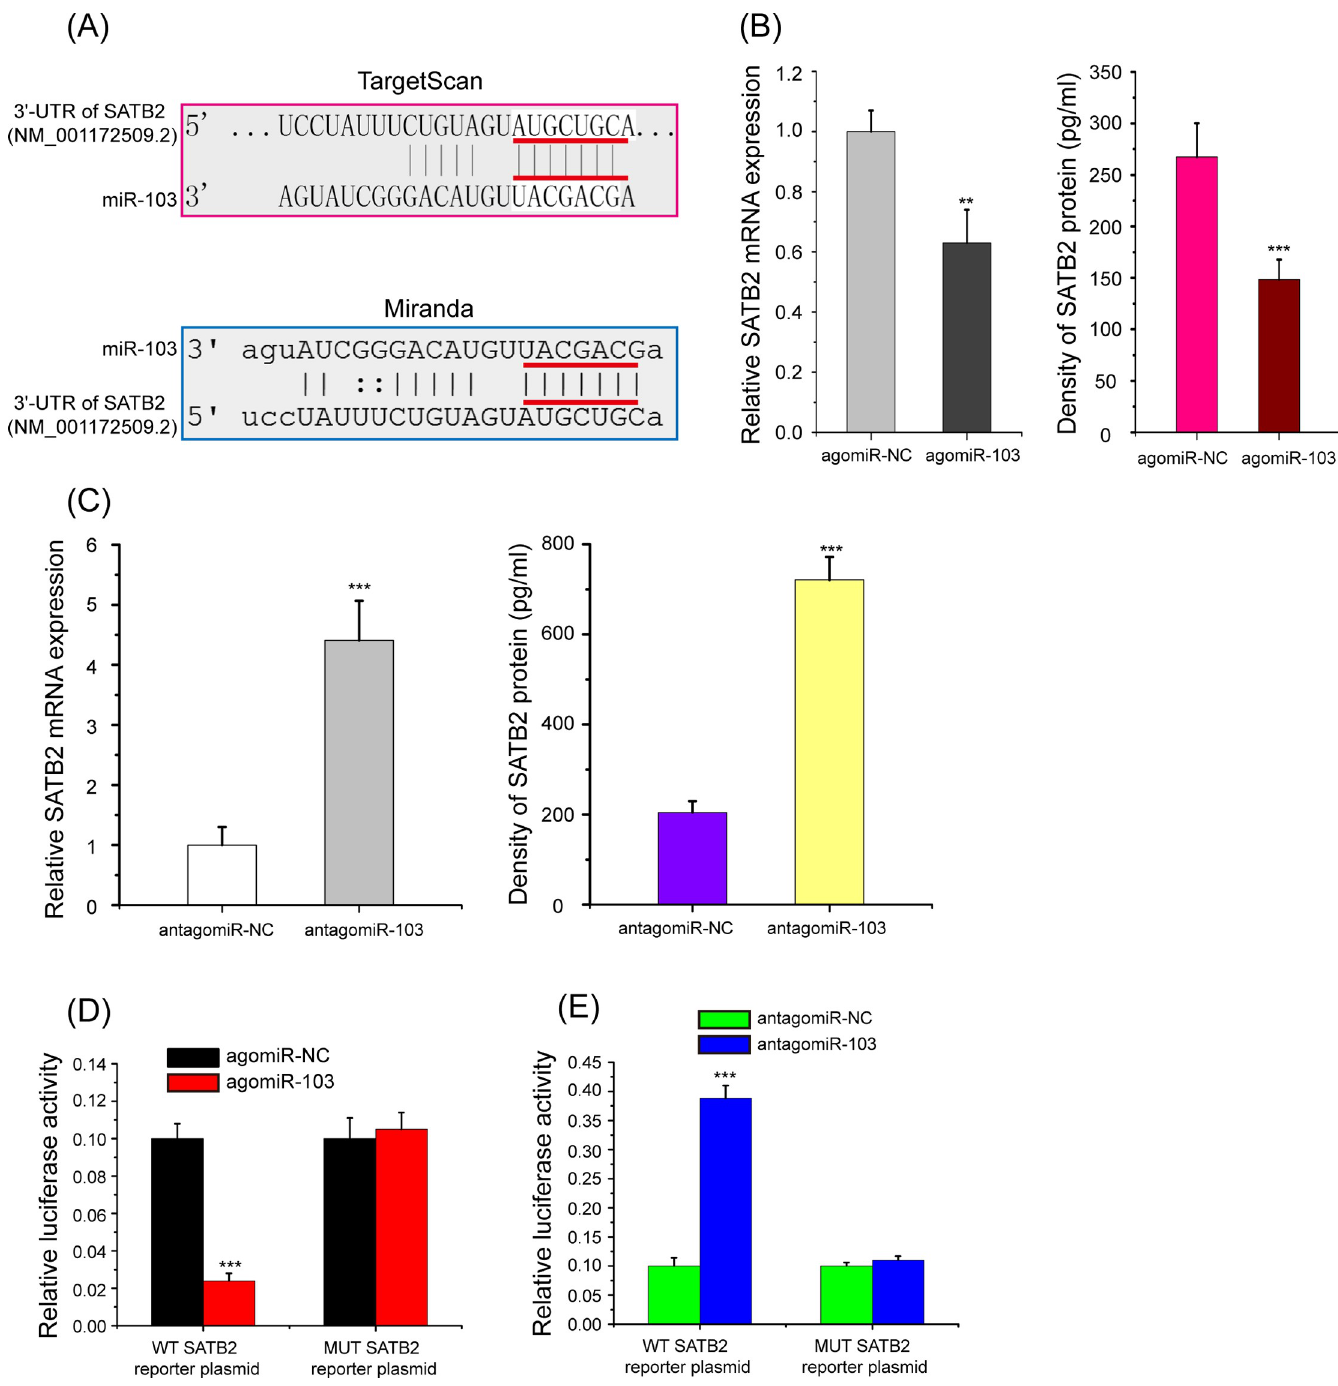
Fig 4. SATB2 is a direct target of miR-103 in HBMScs. (A) miR-103 target sites in the 3’-UTR of SATB2 mRNA. (B) Real-time qPCR and ELISA were conducted to examine the effects of miR-103 overexpression on the mRNA and protein expression of SATB2. GAPDH was also detected as a loading control. (C) Knockdown of miR- 103 markedly upregulated SATB2 mRNA and protein expression in HBMScs. (D) Relative luciferase activity of the WT or MUT SATB2 reporter plasmids along with agomiR-103 or agomiR-NC in HBMScs was shown. Renilla luciferase activity was normalized to Firefly luciferase activity and plotted as relative luciferase activity. (E) Luciferase activities were measured in HBMScs following cotransfection with the WT or MUT SATB2 reporter plasmids and antagomiR-103 or antagomiR-NC. Data are shown as the mean ± SD of three independent experiments. �� p < 0.01, ��� p < 0.001.